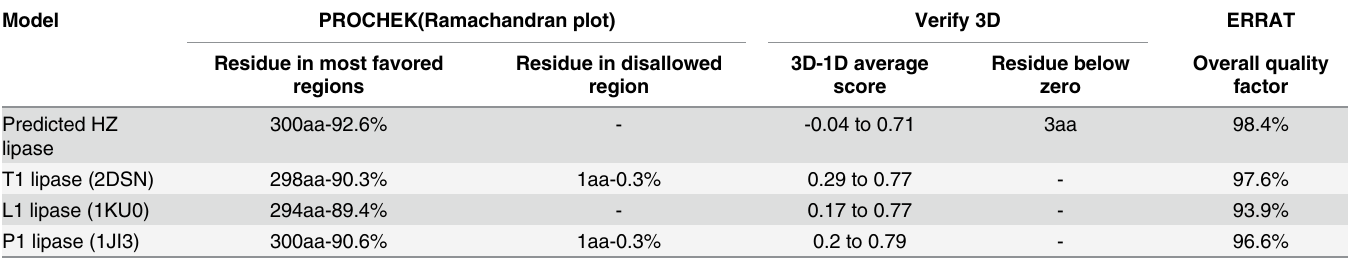
Table 2. Summary of evaluation of predicted model of HZ lipase and T1, L1 and P1 lipases structure.